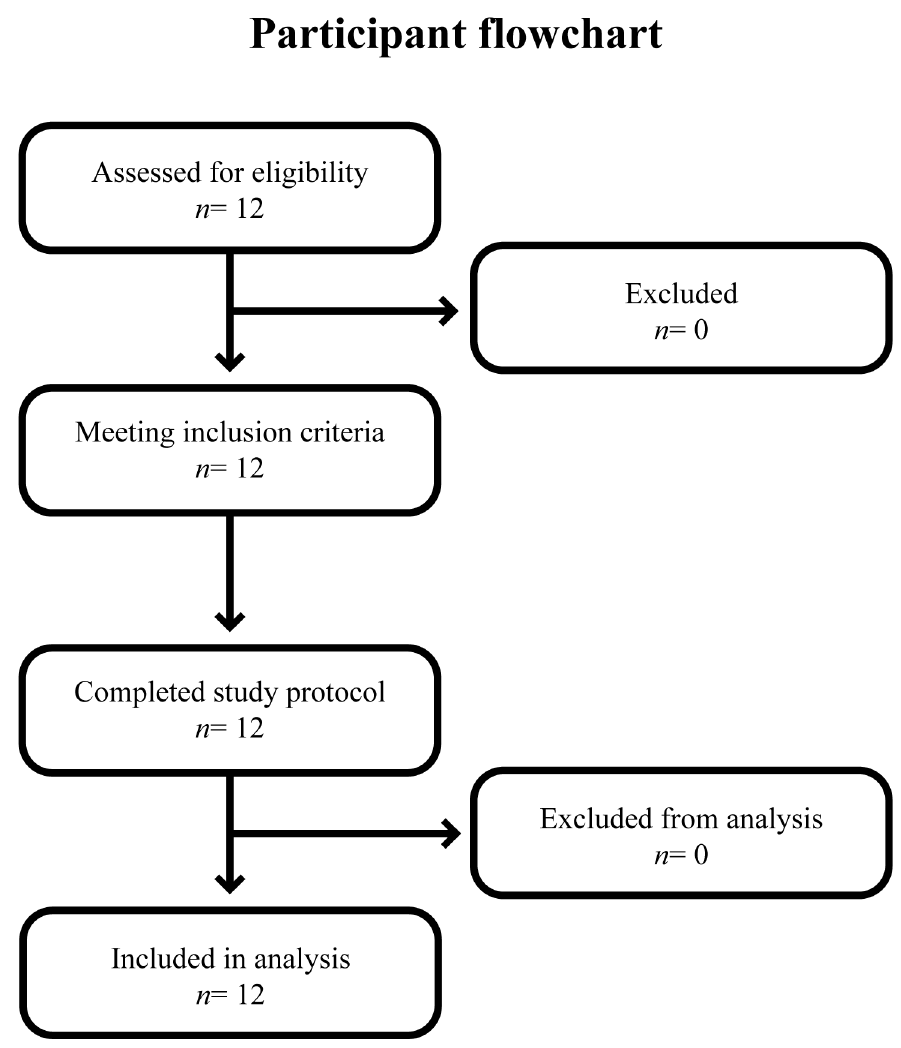
Fig 1. Flowchart of